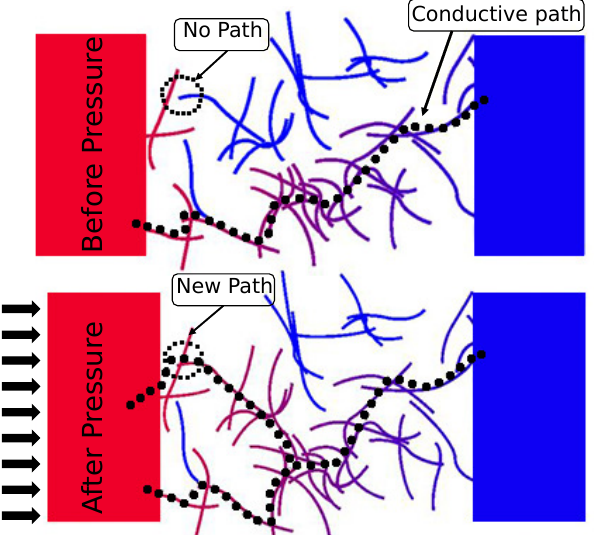
Figure 5. 2D Model of randomly dispersed CNTs between two electrodes. For clarification purposes, the CNTs are not drawn to scale in this